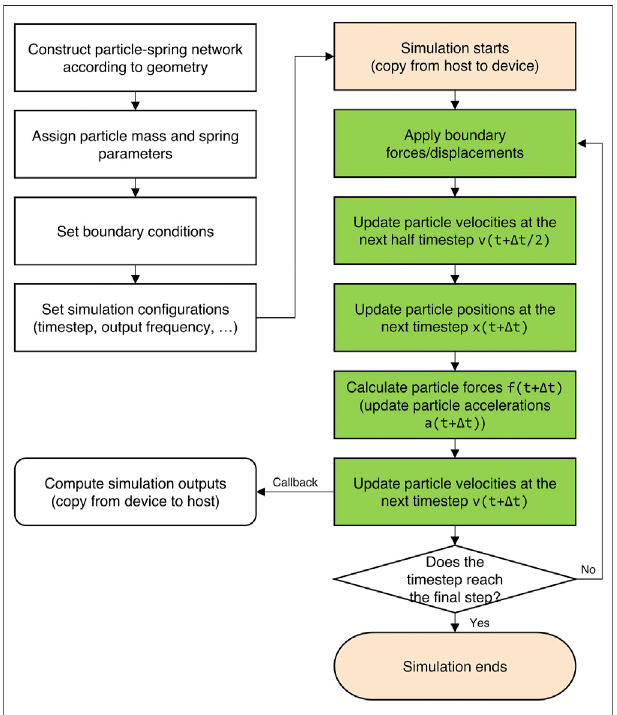
FIGURE 2 | Computing fl owchart in CuLSM. The green blocks are implementedbyGPUkernels,whichparallelizeparticleandspringvectors.Ateach iteration,timestepischeckedifsatisfyingtheconditionsforcallbackortermination.